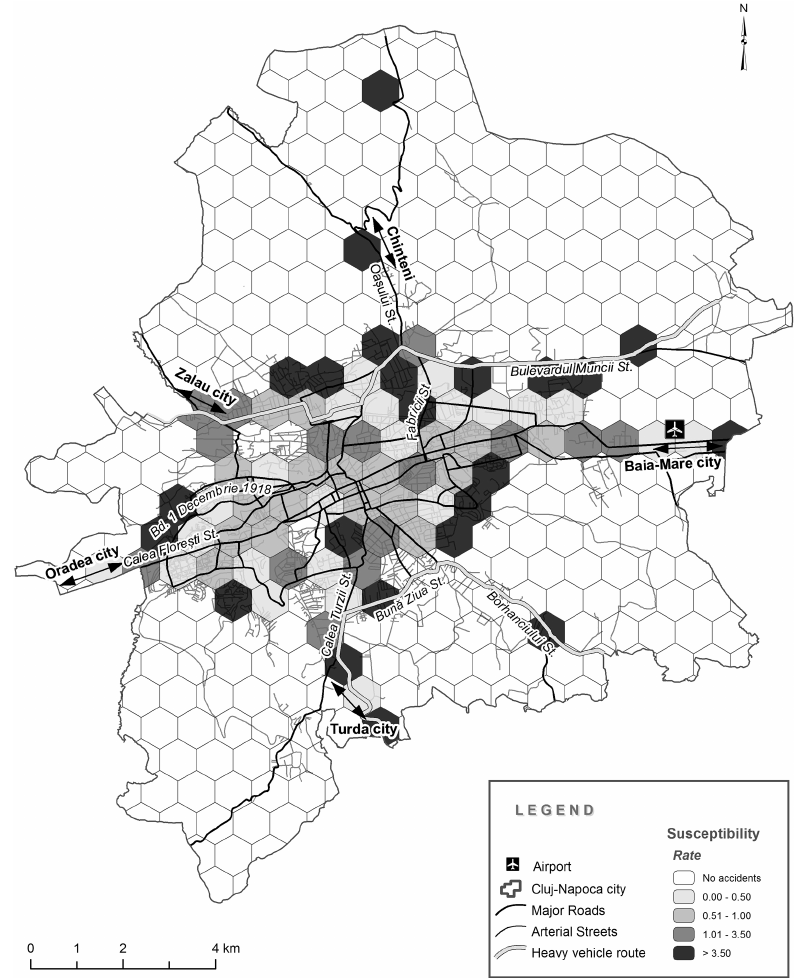
Figure 2. The map of areas susceptible to traffic accidents under low-light conditions in Cluj-Napoca (2010–2014).